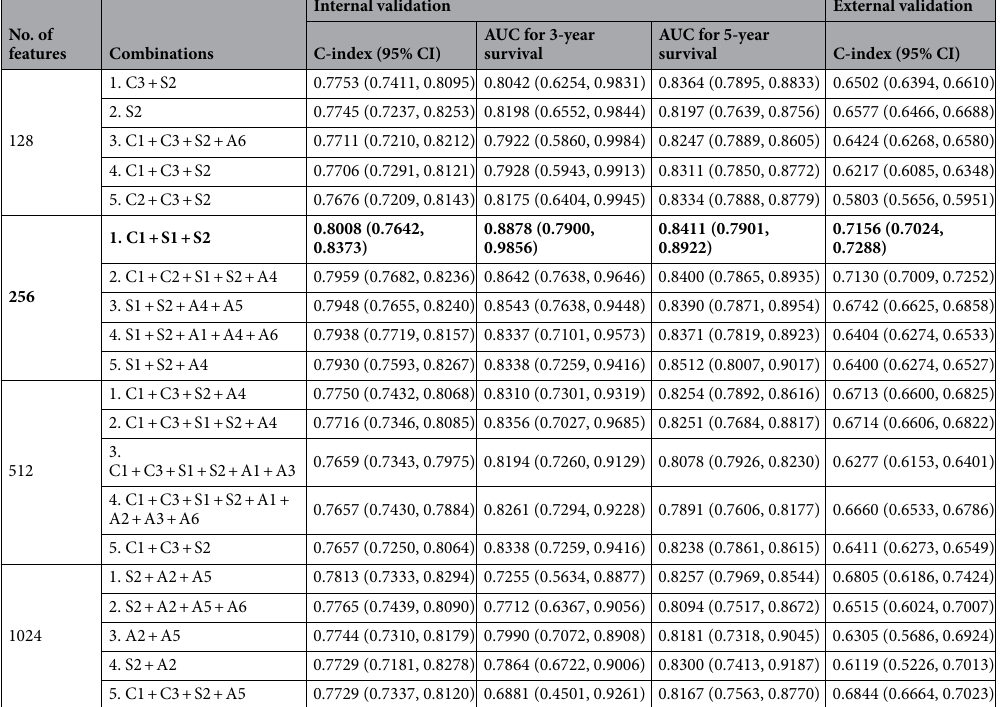
Table 2. Survival prediction performance of deep features in the discovery and external validation cohort. C1, C2, C3 coronal slices at the vertebral body, center of the tracheal carina, and superior vena cava, respectively; S1, S2 sagittal slices at the right and left lung, respectively; A3 axial slice at the center of the tracheal carina; A1, A2, A4, A5, A6 upper two and lower three axial slices at 2-cm intervals at the center of the tracheal carina, respectively. Bold values denote best-performed combinations of each